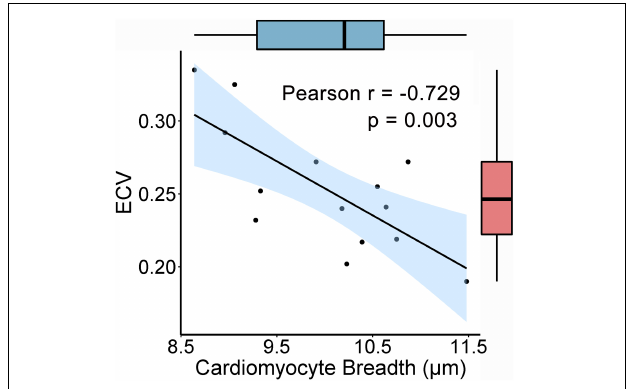
FIGURE 4 | Correlation between the ECV and the CmyB. The ECV is negatively correlated with the CmyB ( r = − 0.729, p = 0.003, n = 14). 95% confidence interval of the correlation coefficient r values is presented as the light blue area, and the box plots showed that there were no potential outliers of the ECV and CmyB. ECV indicates extracellular volume fraction; CmyB, cardiomyocyte